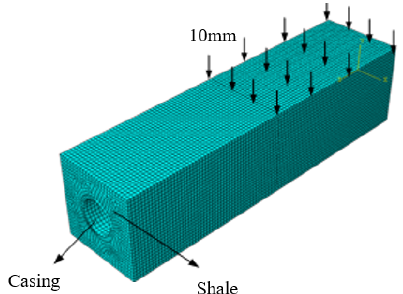
Figure 22. Mesh diagram of finite element analysis.